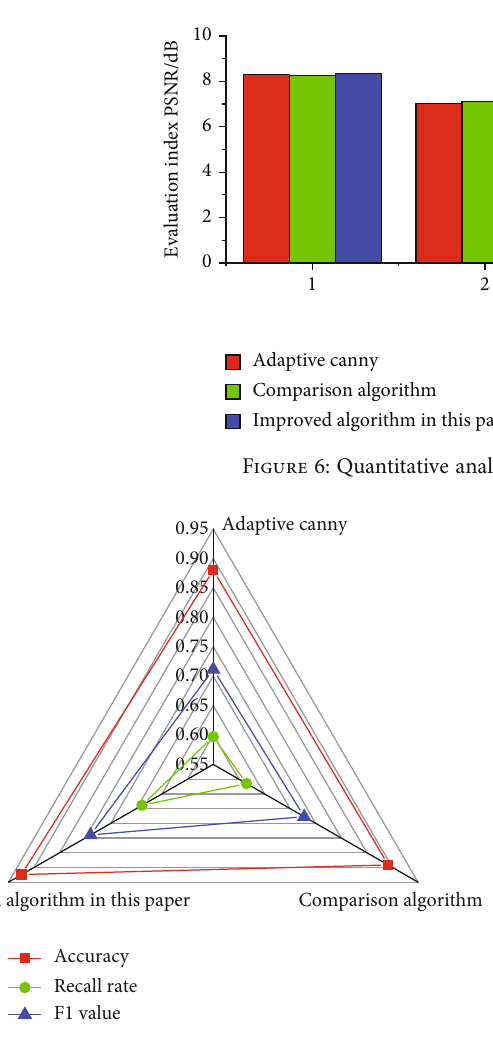
Figure 7: Analysis of segmentation results of three algorithms.